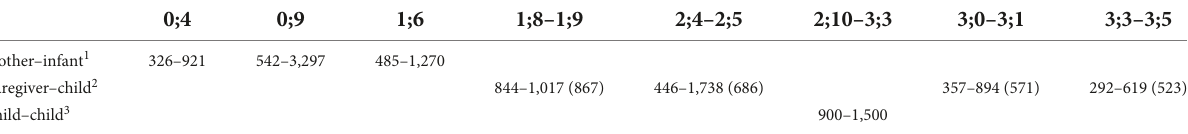
TABLE 5 Timing data (gap length between turns) from infants and children in